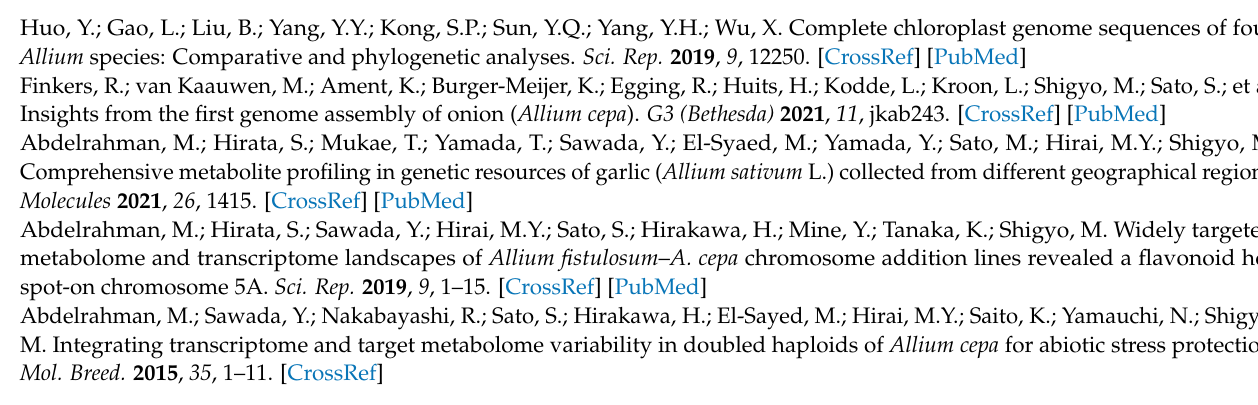
Table S5: List of overlapping differentially produced metabolites [DPMs, q -values ≤ 0.05; log 2 (fold- changes) ≤ − 1 and log 2 (fold-changes) ≥ 1 for decreased and increased metabolites, respectively] in ‘shallot vs. SDO’, ‘shallot vs. LDO’ and/or ‘LDO vs. SDO’ comparisons. Values represent metabolite log 2 (fold-changes). Red and blue colors indicate overlapping increased and decreased levels of metabolites, respectively, in different comparisons.; Table S6: List of organosulfur-related compounds successfully identified in Japanese short-day and long-day onion (SDO and LDO, respectively) va- rieties, and Indonesian shallots grown under normal growth conditions, as determined by liquid chromatography–mass spectrometry (LC-MS). Data represent average mean (mg g − 1 DW) of three replicates ( n = 3).; Table S7: Setting parameters of LC-QqQ-MS analysis of Indonesian shallots